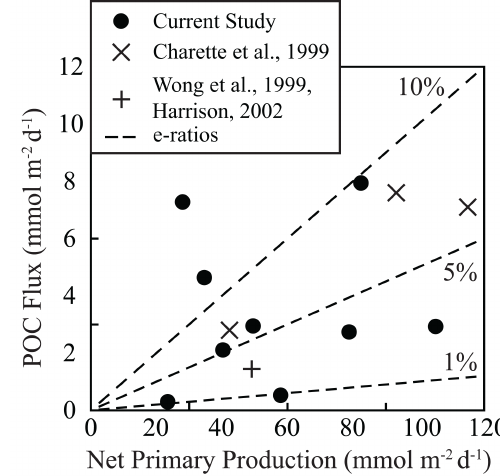
Figure 10. Net primary production (NPP) plotted against 234 Th- derived POC fluxes ( P POC ) for stations along Line P in this study. The slopes of the dashed lines represent ThE ratios. For reference, NPP and P POC values determined by Charette et al. (1999) for win- ter, spring, and summer are included, along with annual average NPP and sediment trap POC fluxes (at 200m) reported in Harri- son (2002) and Wong et al. (1999),